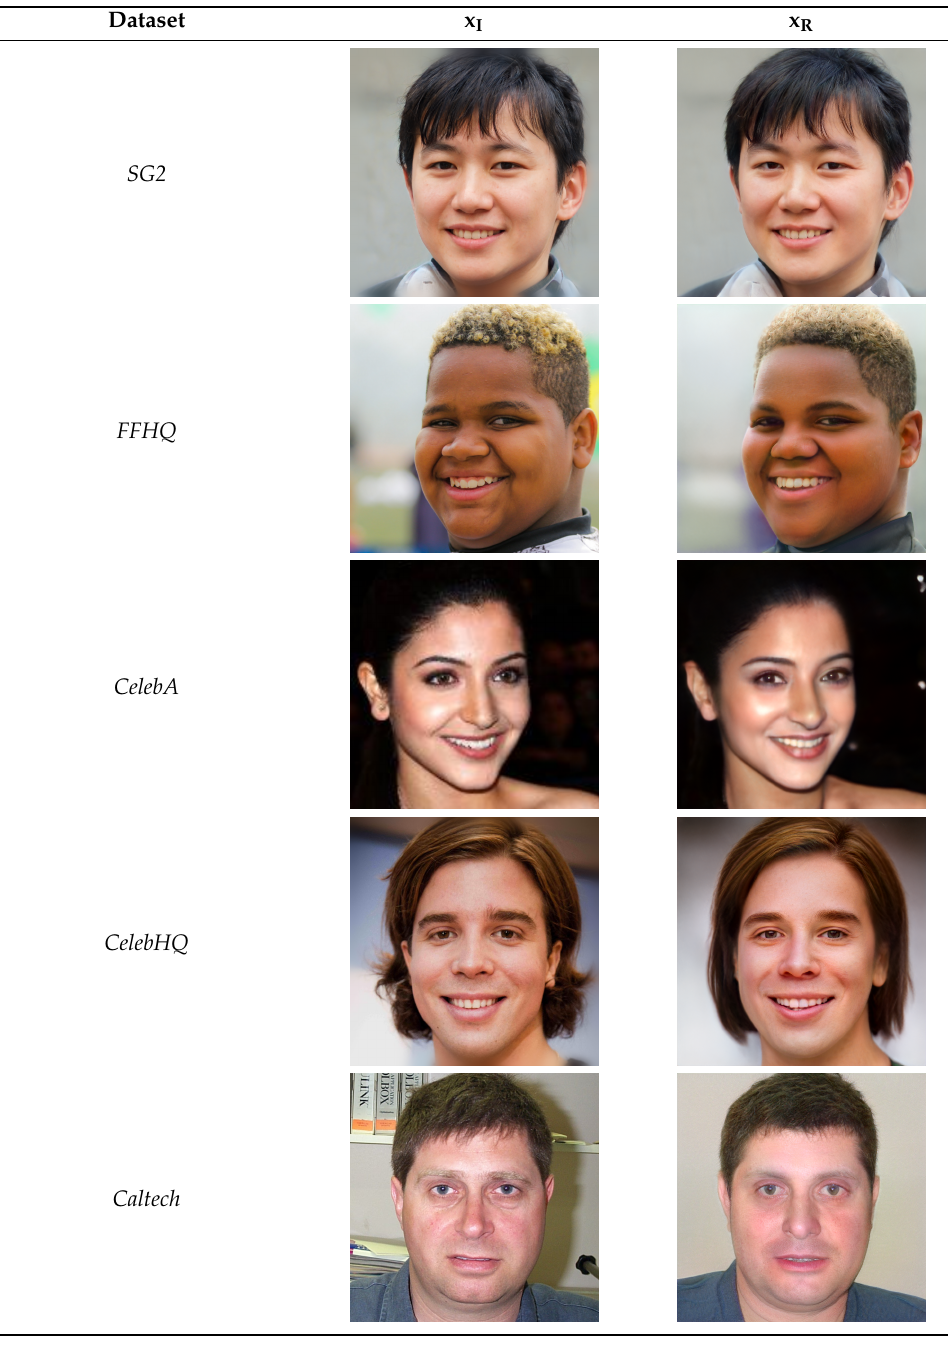
Table 1. Examples of input face images and their